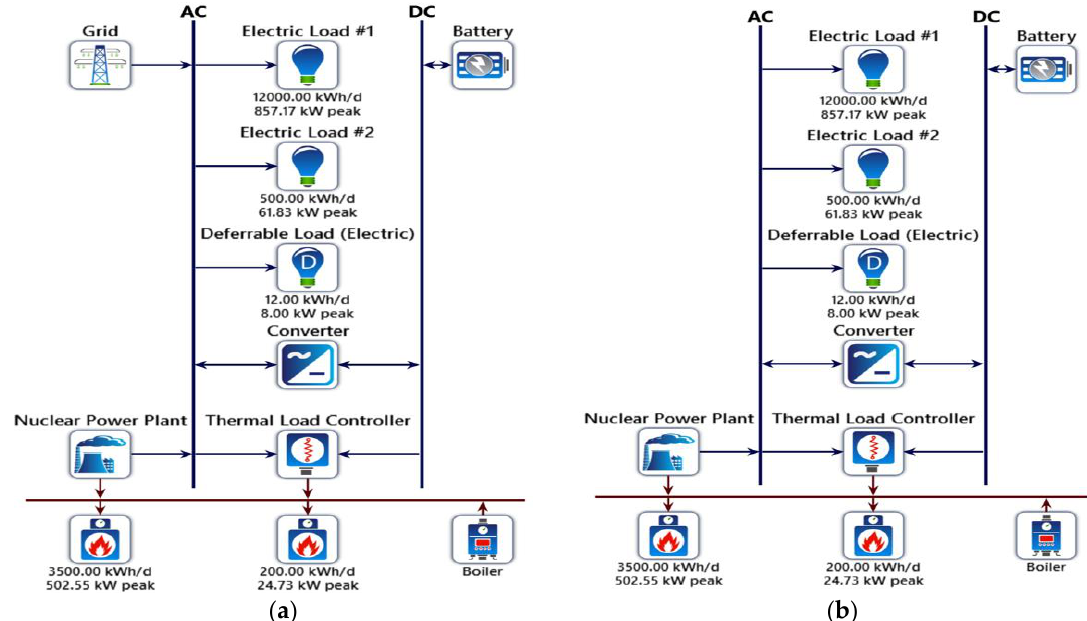
Figure 11. ( a ) Small-scale grid-connected stand-alone nuclear energy system; ( b ) Small-scale off-grid stand-alone nuclear energy system. Table 13. Energy production and consumption scenario of grid-connected mode for the first year of project life (case-04).